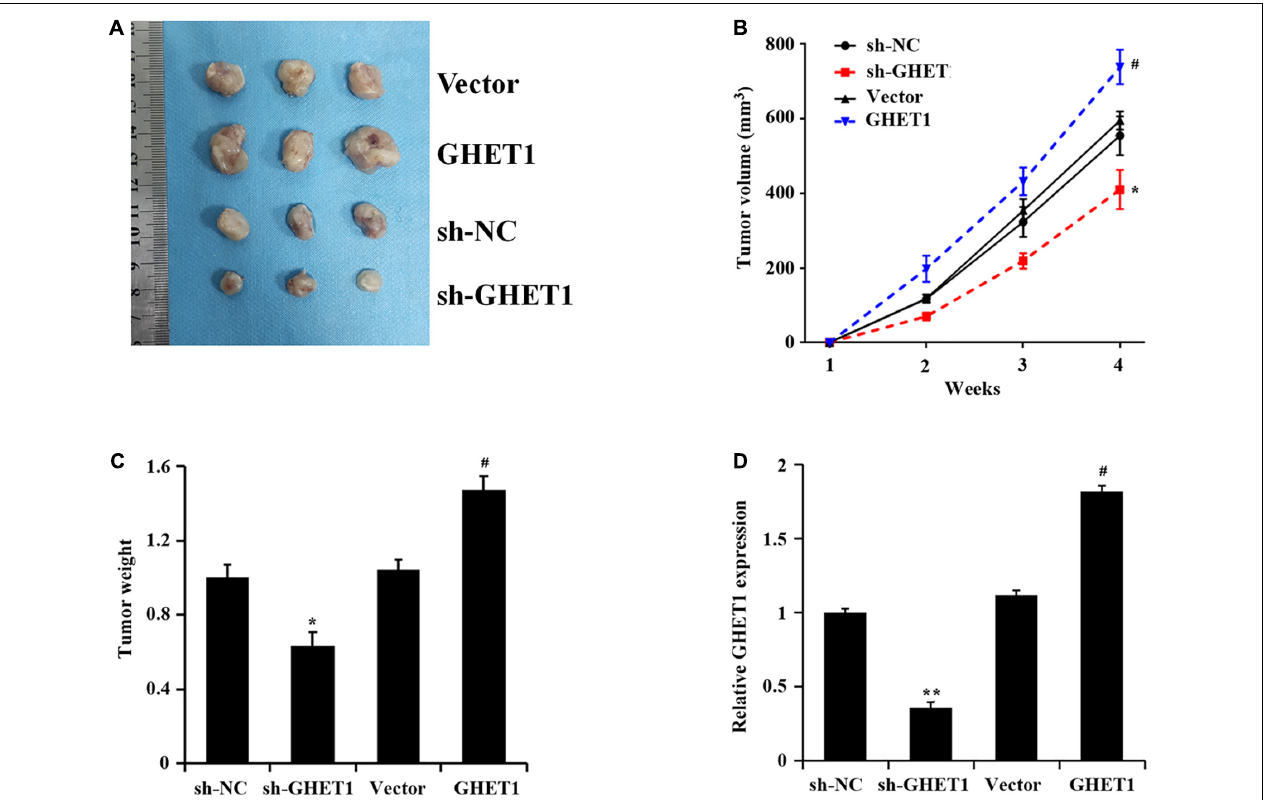
FIGURE 5 | lncRNA GHET1 promoted the tumor growth in nude mice. (A) Typical TNBC tumor from tumor bearing mice after subcutaneous injection of HCC1937 cells stably overexpression and underexpression lncRNA GHET. (B) The TNBC tumor volume from tumor bearing mice after treatment. (C) The tumor weight from tumor bearing mice after treatment. (D) Expression of lncRNA GHET1 in xenograft tumor tissues as determined by qRT-PCR. * p < 0.05 and ** p < 0.01 vs. sh-NC group; # p < 0.05 and ## p < 0.01 vs. Vector